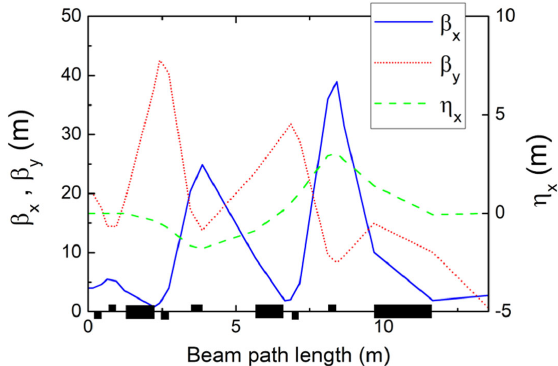
FIG. 2. Twiss parameters along the gantry beam line (without rotation; 0 degree from the vertical position). Blue curve: horizontal beta function; red curve: vertical beta function; green curve: horizontal